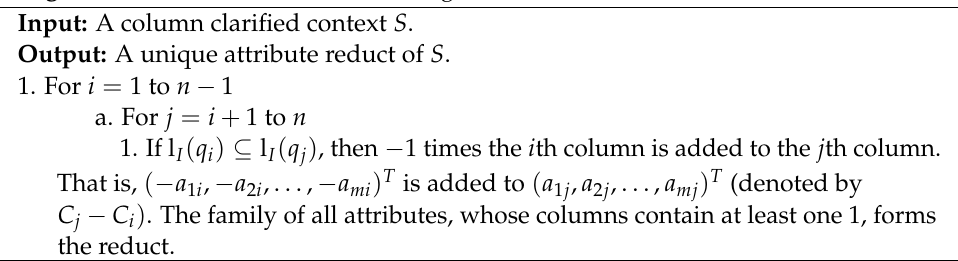
Algorithm 1: An attribute reduction algorithm for